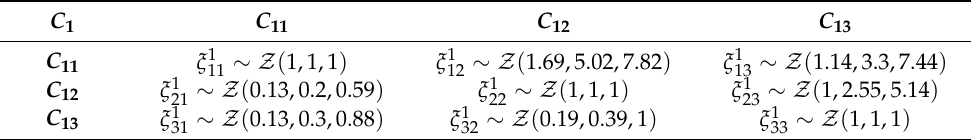
Table 8. Uncertain matrix for criteria C 11 , C 12, and C 13 .